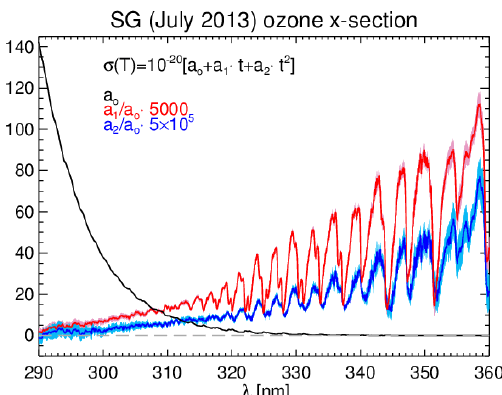
Figure 4. Same as Fig. 2, but for SG (July 2013 version)